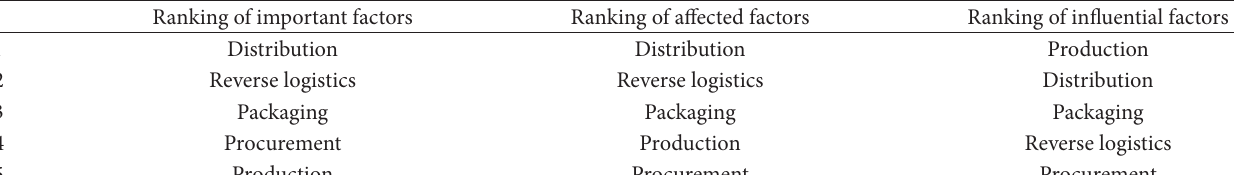
Table 8: Ranking dimensions of green logistics.